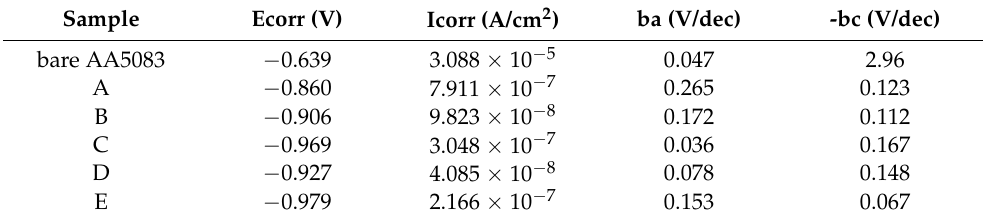
Table 2. The extracted parameters from the polarization curves of different pretreated AA5083 coated with